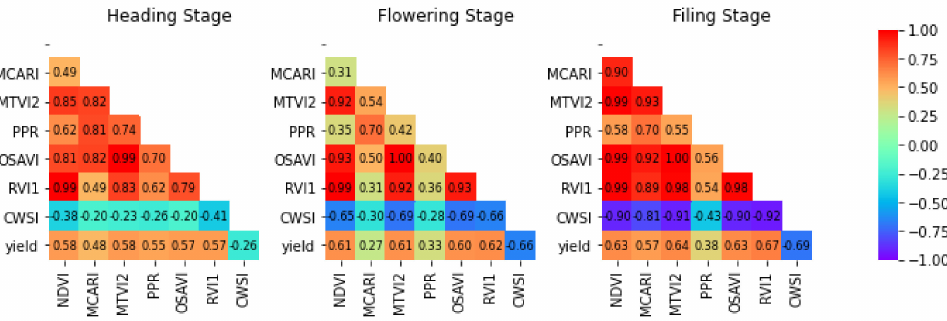
Figure 8. Correlation analysis heat map in the heading stage, flowering stage, and grain-filling stage,